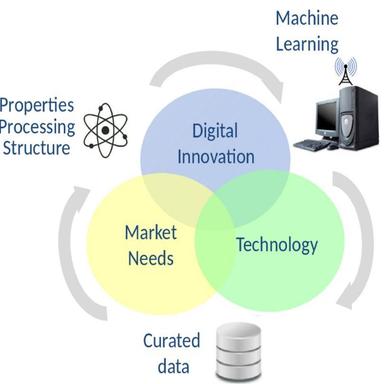
Interrelations between Digital Innovation – Technology – Market Needs .